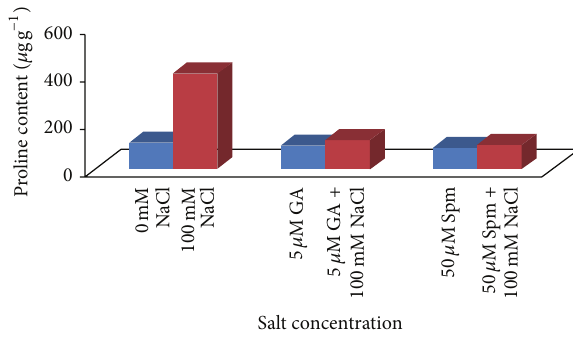
Figure 5: Effect of NaCl on the total chlorophyll content of 10- day-old mungbean seedling and its possible amelioration with 5 𝜇 M GA 3 and 50 𝜇 M Spm.